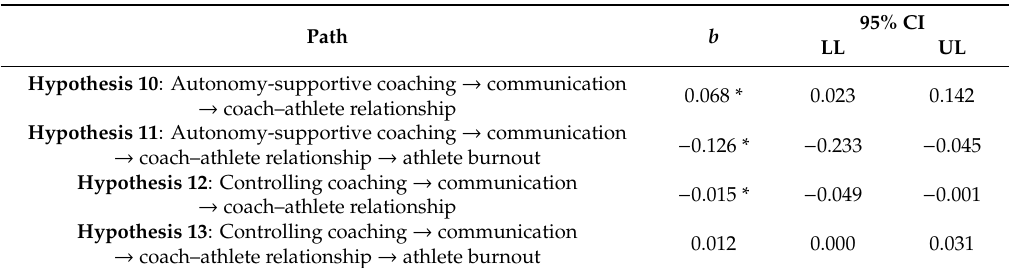
Table 5. Estimates of mediation e ff ect.